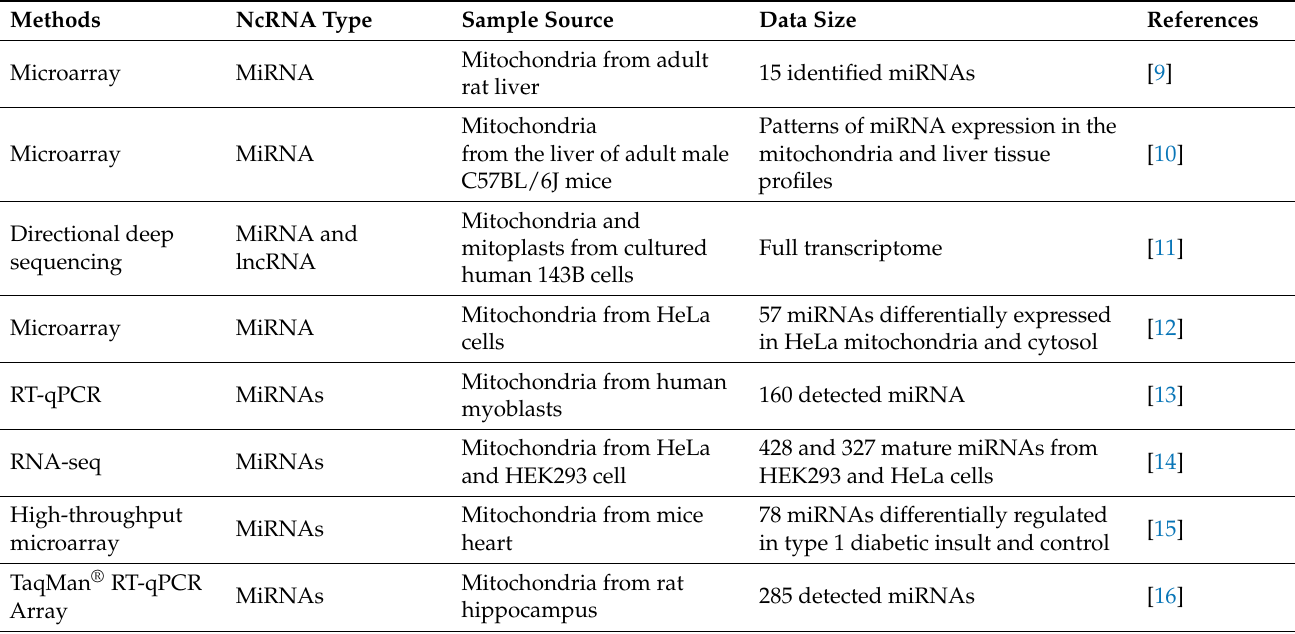
Table 1. The detail of mitochondrial ncRNA